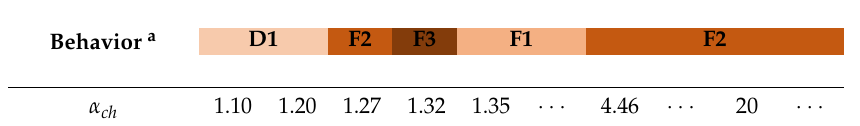
Table 2. Summary of the leaching-tubing-like systems behavior with the vibration of α ch from 1.10 to 20.